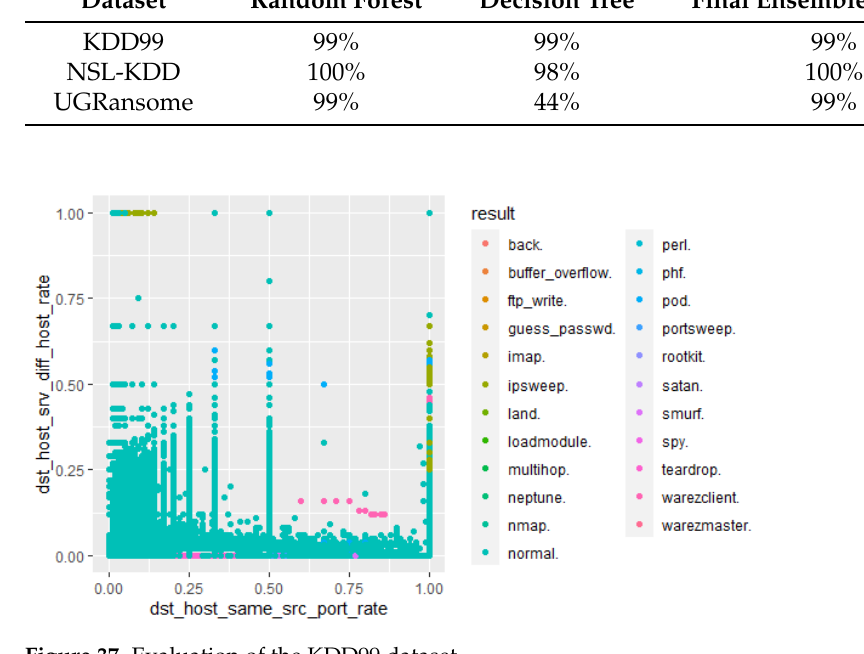
Figure 37. Evaluation of the KDD99